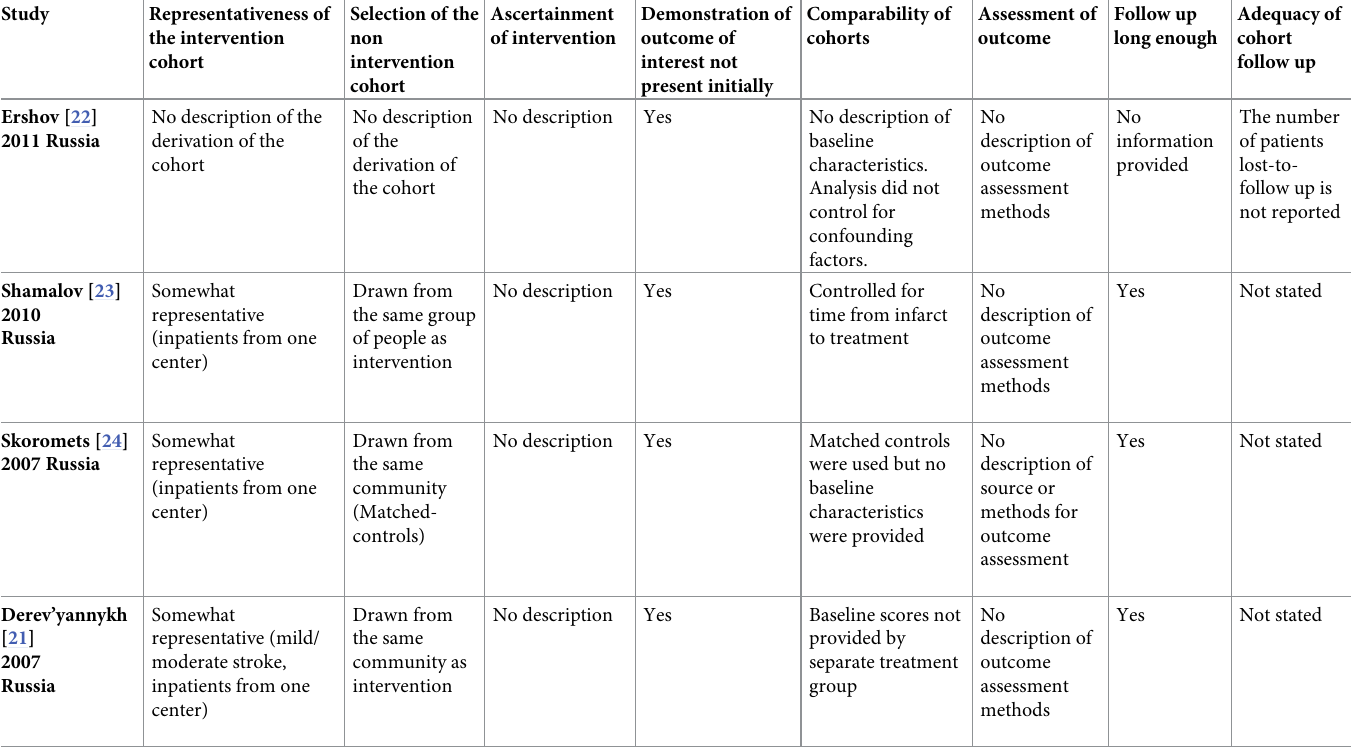
Table 3. Newcastle Ottawa Risk of Bias Assessment of Observational Studies–cohort